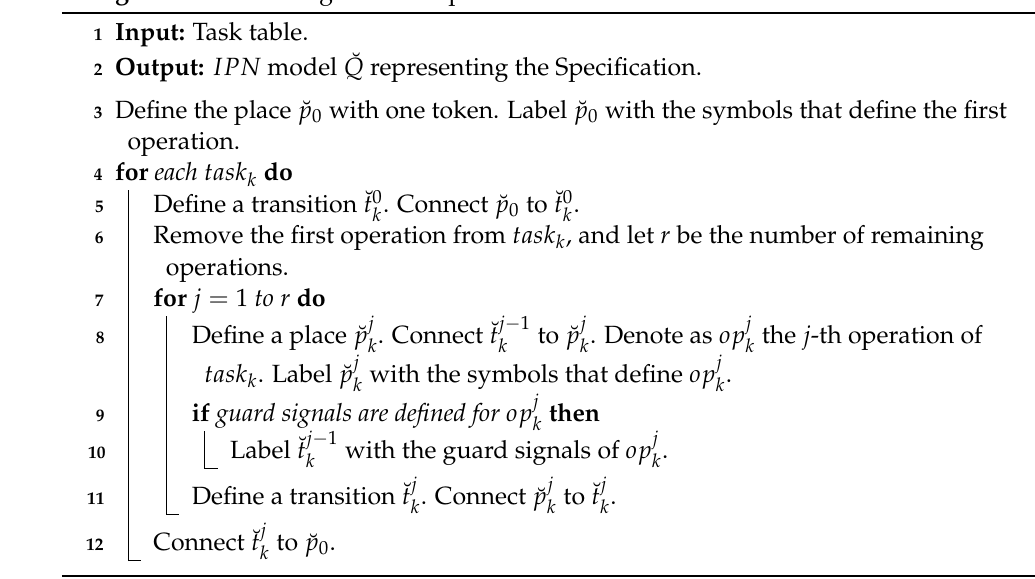
Algorithm 2: Building the IPN Specification.